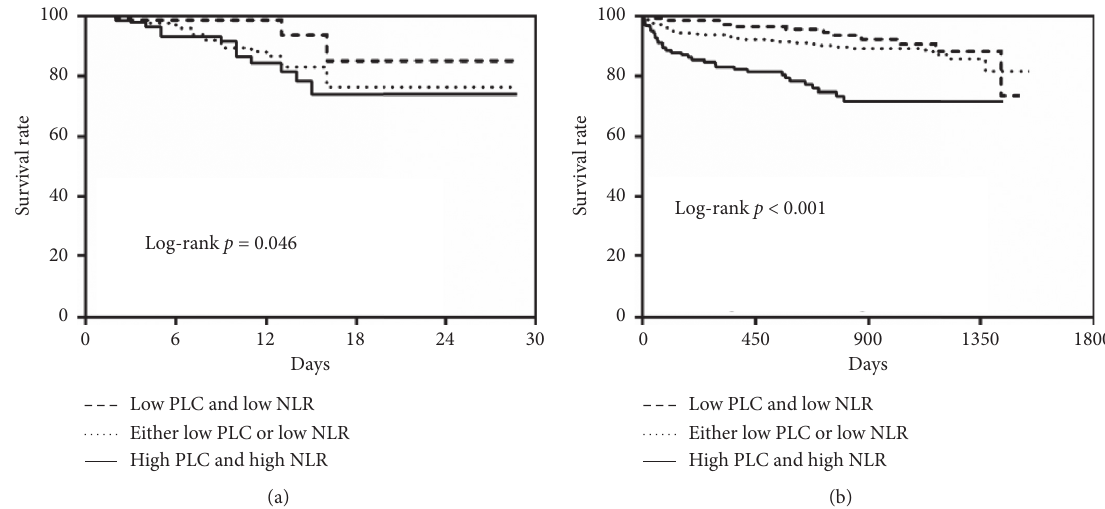
Figure 4: The all-cause mortality based on the combination of PLC and NLR. (a) Kaplan–Meier survival curve of in-hospital mortality. (b) Kaplan–Meier survival curve of long-term mortality. Abbreviations: PLC, platelet count; NLR, neutrophil-to-lymphocyte ratio.